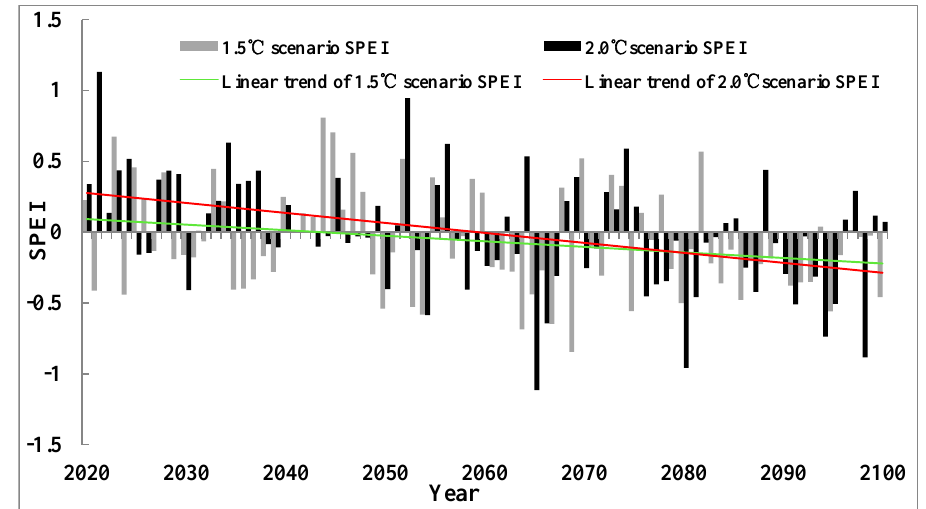
Figure 8. Temporal variation in the annual SPEI in the Songliao Plain maize belt under the 1.5 °C and the 2.0 °C global warming scenarios.